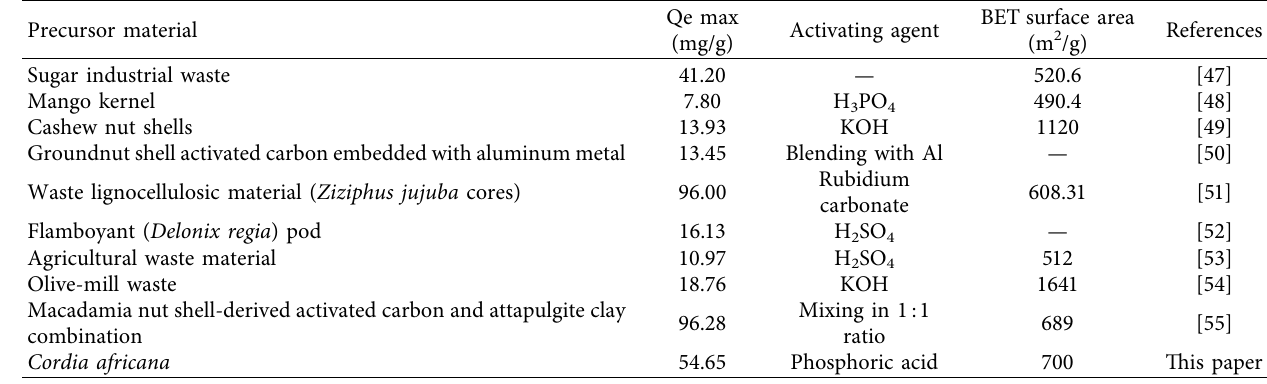
Table 7: Comparison of this research with other research.